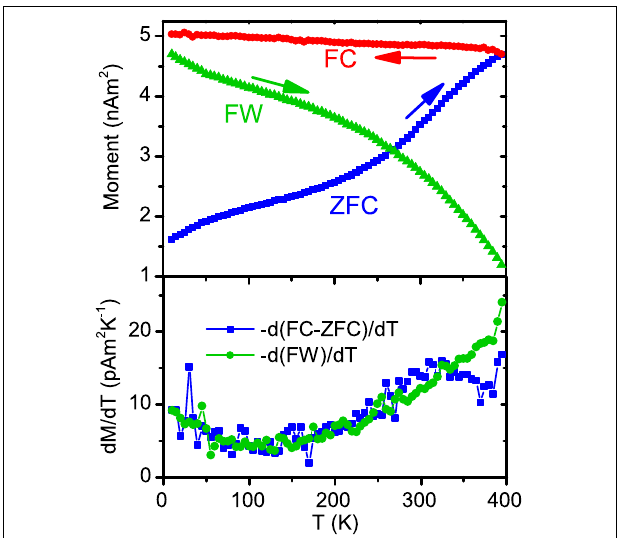
FIGURE 6 | (A) Nanoparticle areal density plotted vs. T B (left) and M r / M s ratio at 395 K (right). Both are a measure of the effective anisotropy of the sample and show a negative correlation with particle density. (B) A simulated random deposition of particles onto a surface at a density of 3000 µ m − 2 , the clusters are not quite at